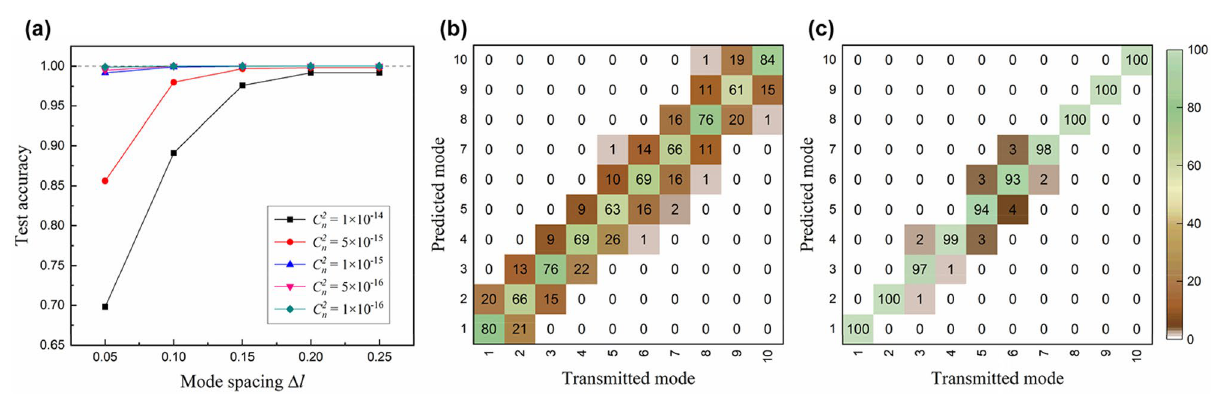
2 n on recognition performance. ( a )